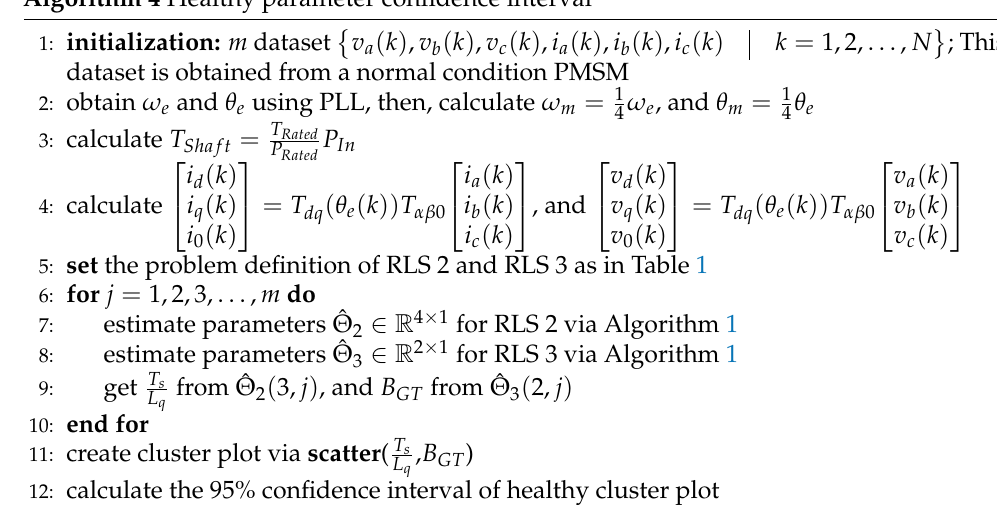
Algorithm 4 Healthy parameter confidence